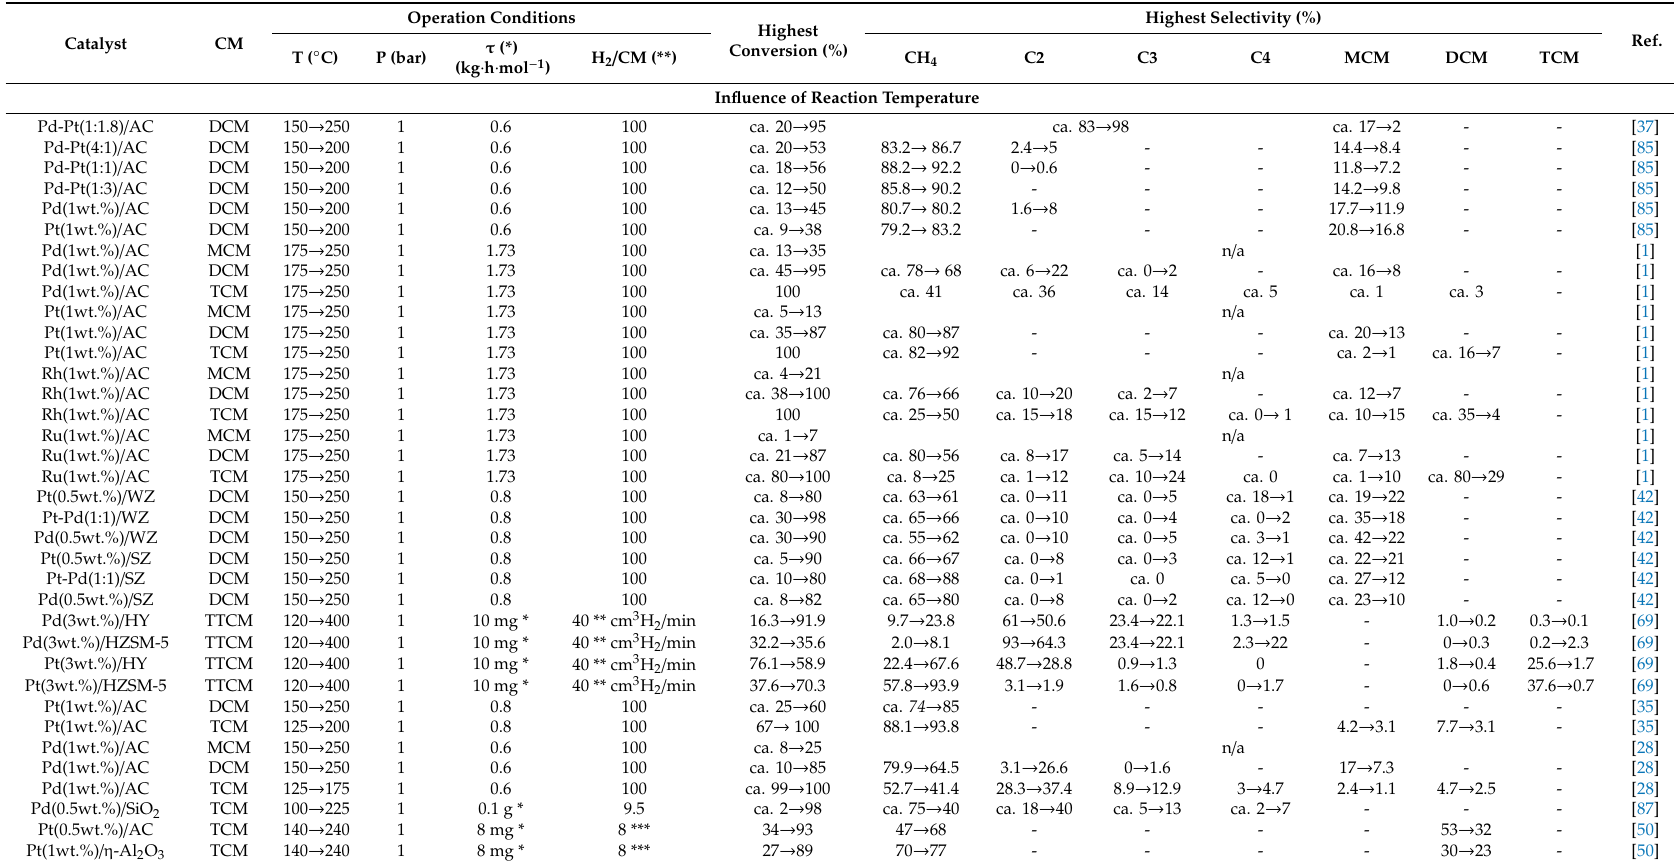
Table A1. Influence of operating conditions in the HDC of chloromethanes (CM). How to read this table: The first line for example, shows that the increasing of the reaction temperature from 150 to 250 ◦ C, leads to an increase in conversion (from 20 to 95%), an increase in selectivity to CH 4 + C2 + C3 + C4 (from 83 to 98%) and a decrease in selectivity to MCM (from 17 to